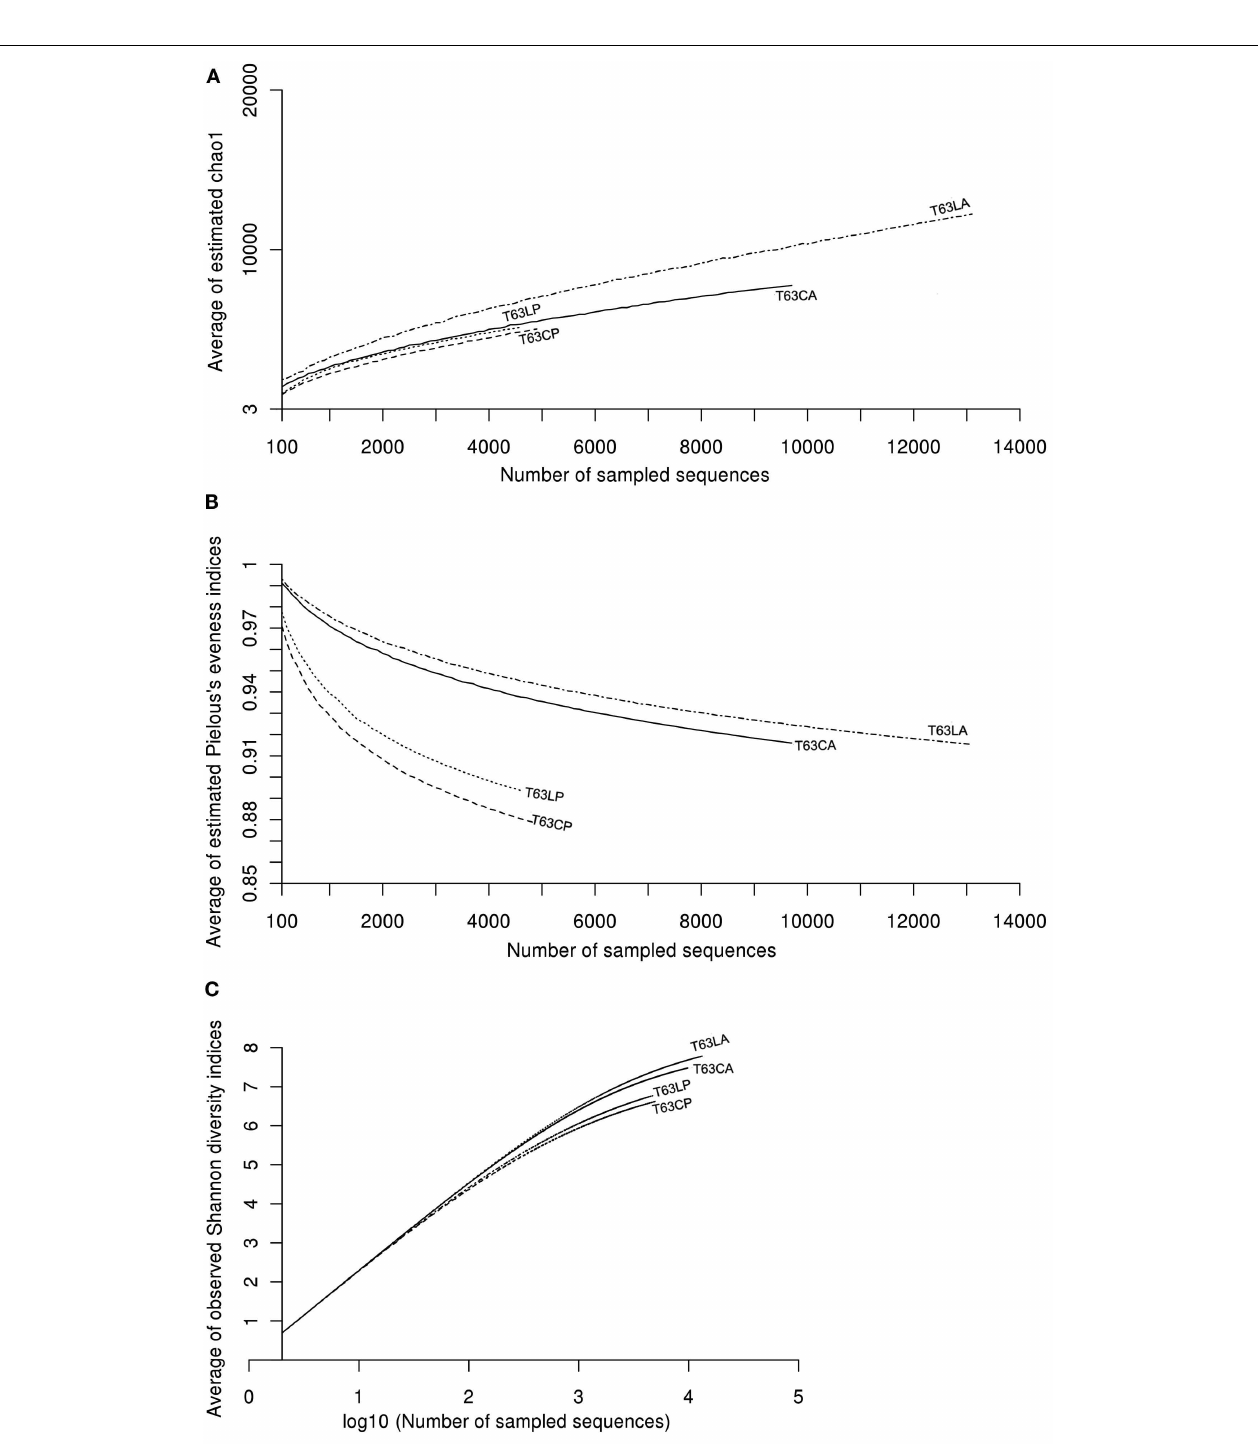
not (LA: Luvisol control, CA: Cambisol control) on day 63 (T63). Average diversity indices were calculated in a similar way to rarefaction analysis with 100 times repeating